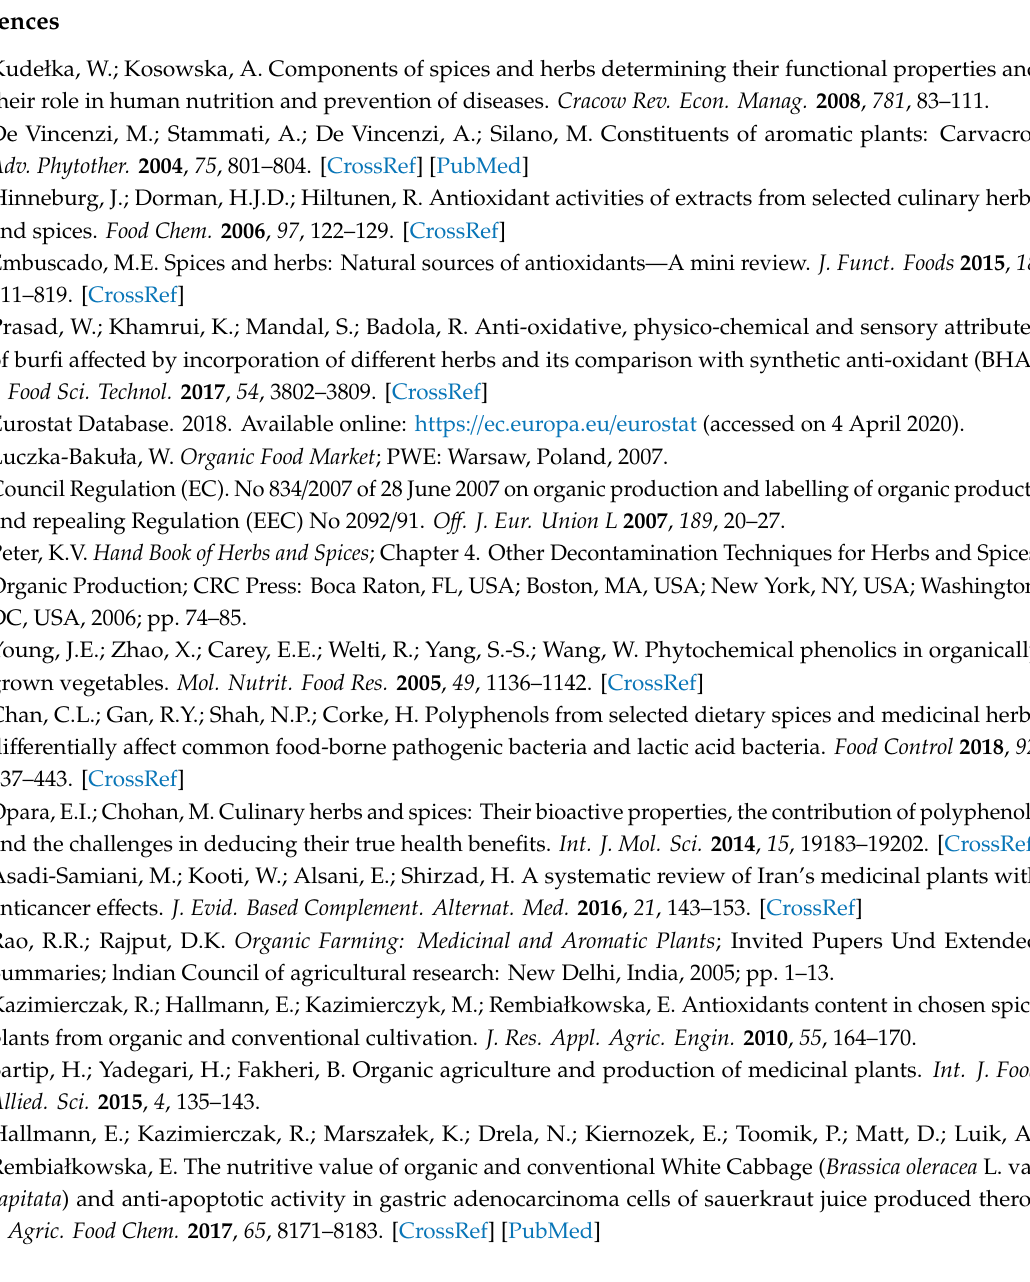
Table S1: The levels of LOD (limit of detection) and LOQ (limit of quantification) for all compounds used in experiment; Table S2. The concentration of individual bioactive compounds (in mg 100 g − 1 of product ) in selected herbs from organic and conventional production in 2017, mean values ± standard error; Table S3. The concentration of individual bioactive compounds (in mg 100 g − 1 of product ) in selected herbs from organic and conventional production in 2018, mean values ± standard